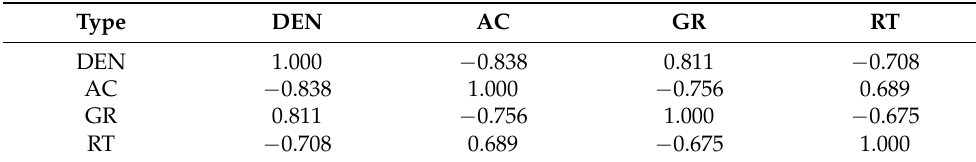
Table 2. The results of correlation matrix for PCA